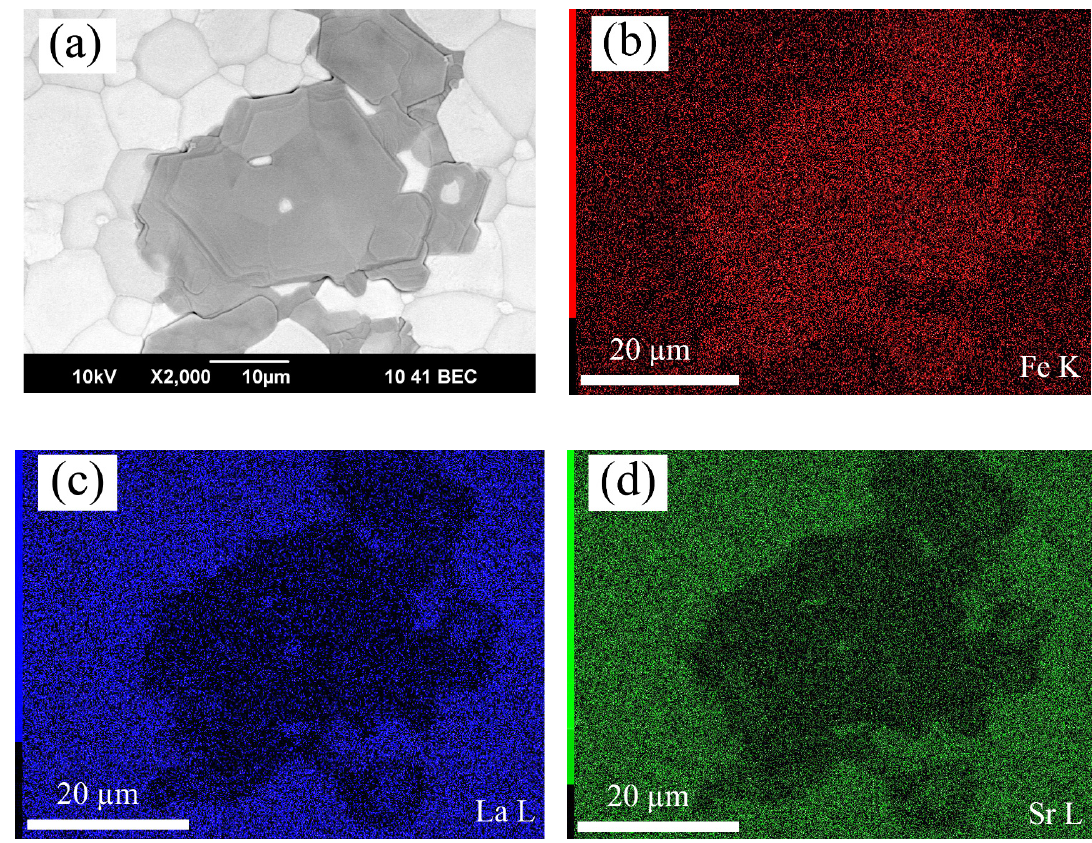
Figure 13. SEM ( a ) and EDX( b – d ) images of La 0.5 − x Sr 0.5 FeO 3 − δ ( x = 0.02) ceramics subjected to heat treatment at 1300 °C for 2 h.